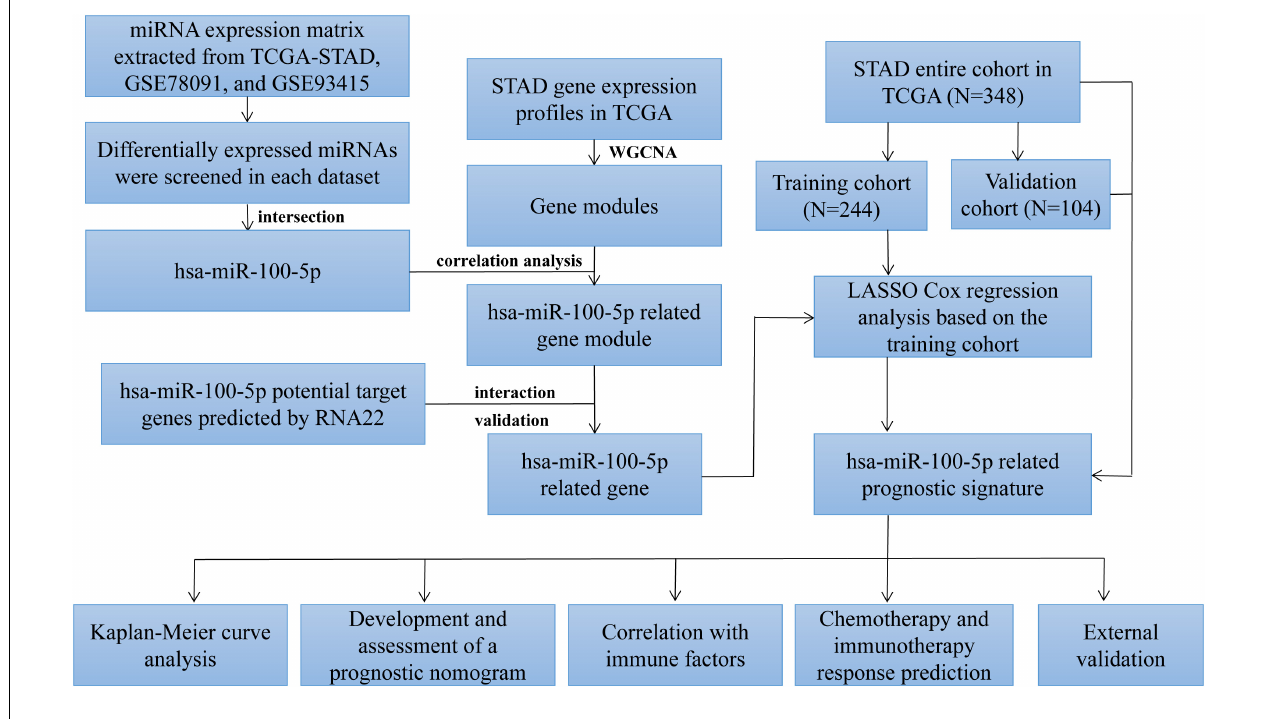
FIGURE 1 | Flowchart of this